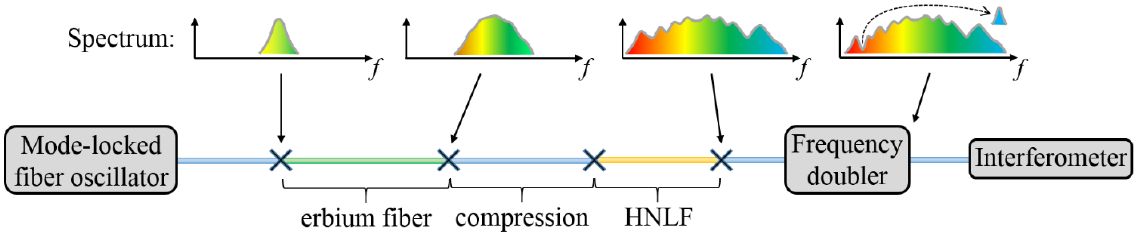
Figure 4: Common design of an amplifier including pulse compression for the supercontinuum generation in a highly nonlinear fiber. The frequency doubler is used to frequency double the long wavelength light. The doubled and the fundamental light is overlapped in the inter-